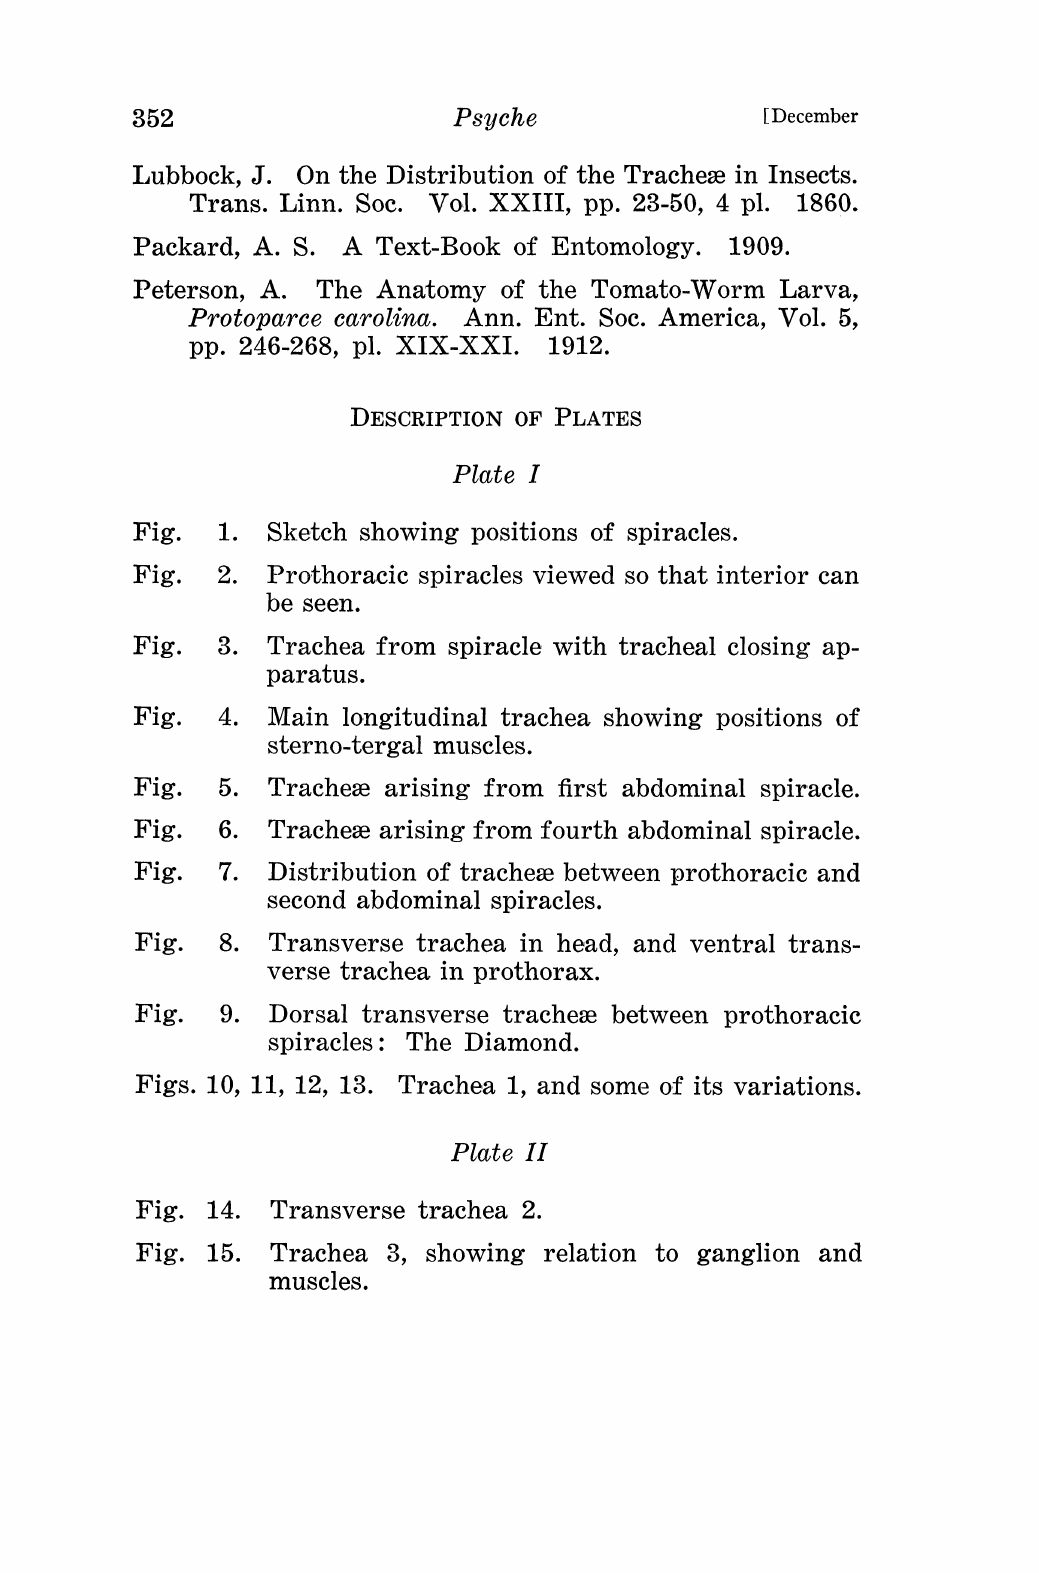
Fig. 1. Sketch showing positions of spiracles. Fig. 2. Prothoracic spiracles viewed so that interior can be seen. Fig. 3. Trachea from spiracle with tracheal closing ap- paratus. Fig. 4. Main longitudinal trachea showing positions of sterno-tergal muscles. Fig. 5. Trachem arising from first abdominal spiracle. Fig. 6. Trachem arising from fourth abdominal spiracle. Fig. 7. Distribution of trachem between prothoracic and second abdominal spiracles. Fig. 8. Transverse trachea in head, and ventral trans- verse trachea in prothorax. Fig. 9. Dorsal transverse trachem between prothoracic spiracles" The Diamond. Figs. 10, 11, 12, 13. Trachea 1, and some of its variations. Plate II Fig. 14. Transverse trachea 2. Fig. 15. Trachea 3, showing relation to ganglion and